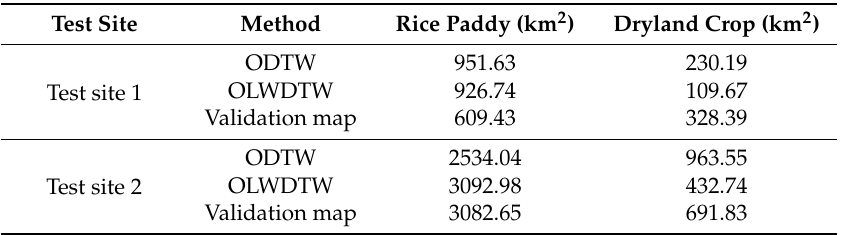
Table 8. Area of rice paddies and dryland crop extracted by the ODTW and OLWDTW methods and the corresponding area on the validation land cover map.